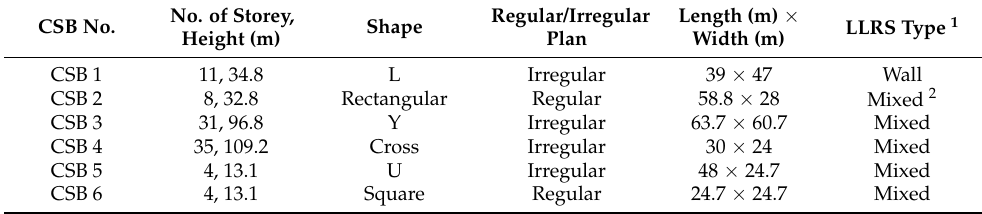
Table 1. Geometrical and structural information of the case study buildings (CSB).